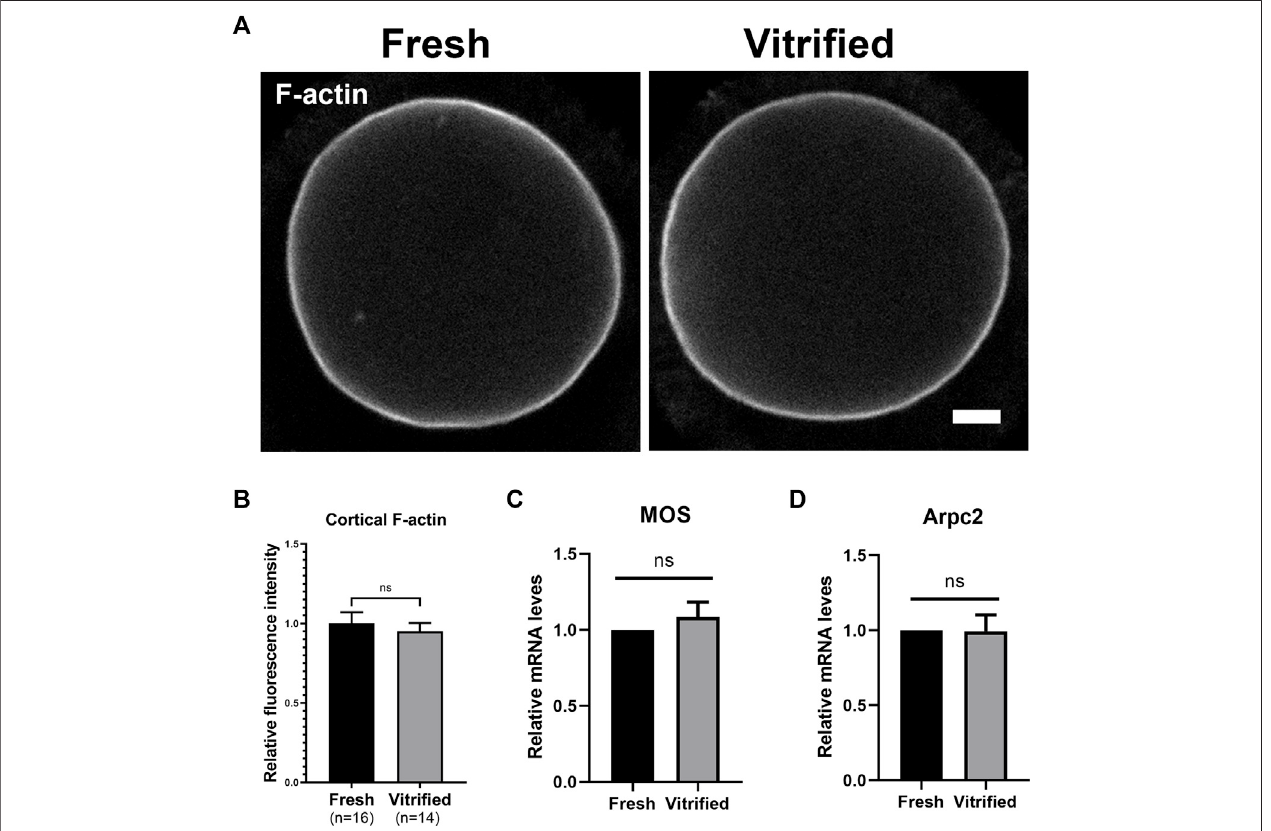
FIGURE 3 | Cortical F-actin level was not affected after vitri fi cation. (A) Representative images of the F-actin in fresh and vitri fi ed oocytes after 9 h cultured. Scale bar = 10 μ m. (B) The relative fl uorescence intensity of cortical F-actin in fresh ( n = 16) and vitri fi ed ( n = 14) groups. (C) The relative Mos mRNA level in BD + 3 h oocytes from different groups. (D) The relative Arpc2 mRNA level in BD + 3 h oocytes from different groups. Data were presented as mean percentage (mean ± SEM) of at least three independent experiments. * p < 0.05, ** p < 0.01, *** p < 0.001, ns, no signi fi cant difference ( p > 0.05).